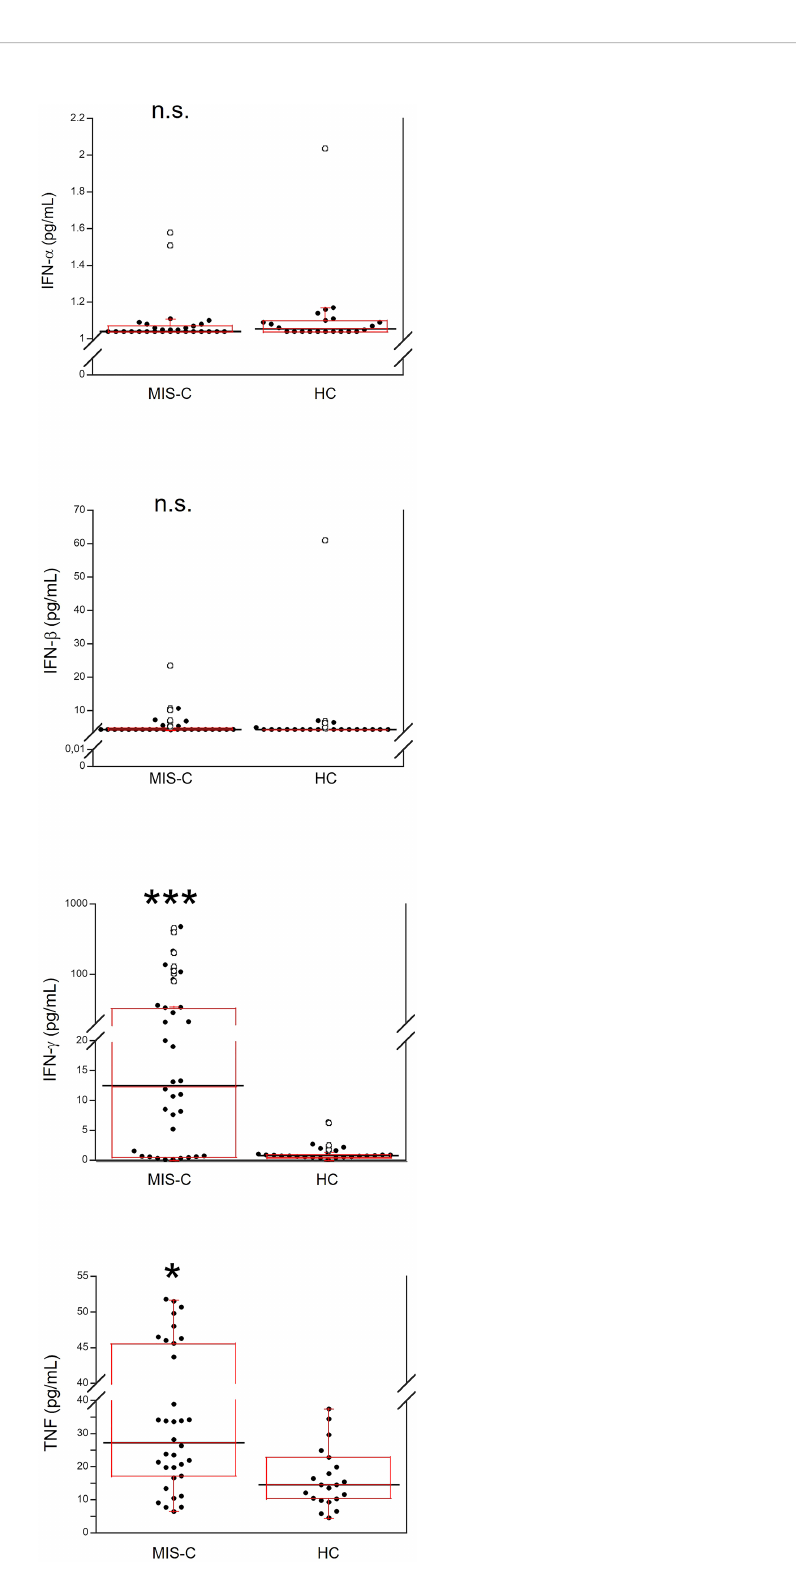
FIGURE 1 Comparison of serum values of IFN- a , IFN- b , IFN- g and TNF in 37 patients with MIS-C and in 24 HC. The black line represents the median value. The red box represents the interquartile range. The blank circles correspond to the outliers and the black circles side by side to these correspond to duplicates *p < 0.01; ***p < 0.0001; n.s.: not signi fi cant (p >